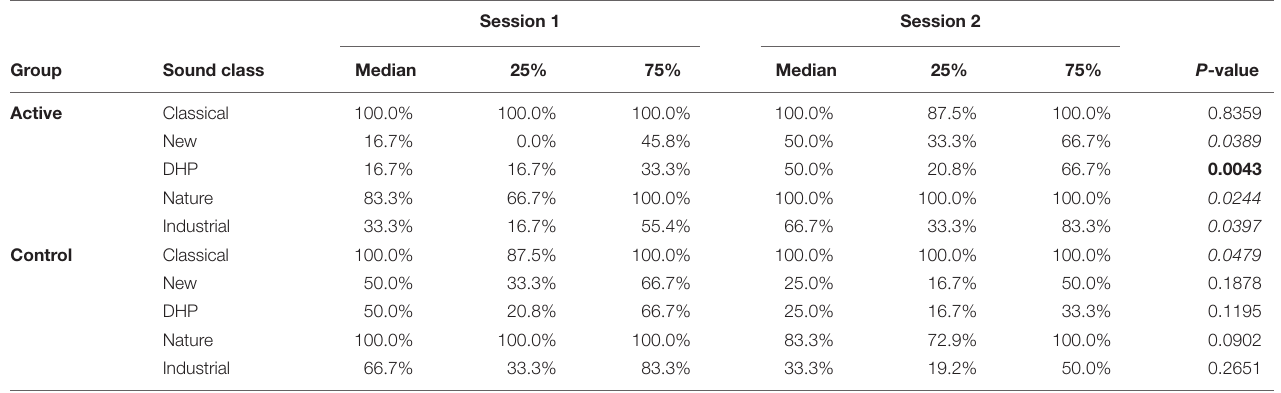
TABLE 1 | Behavioral responses to individual sound classes by group and session.